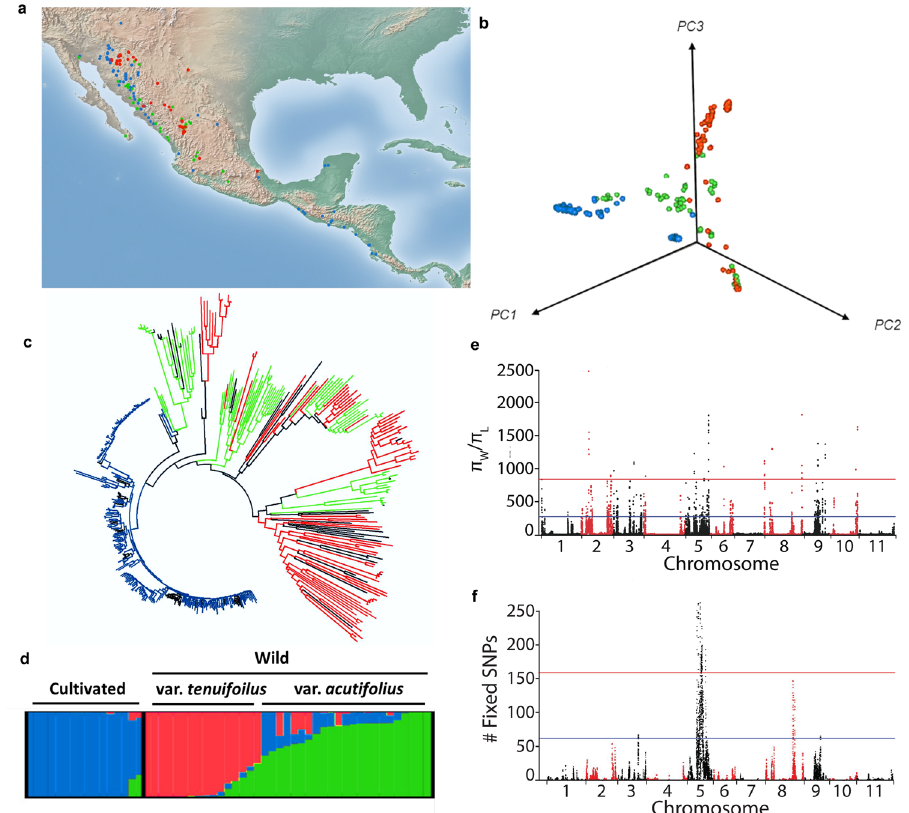
Fig. 4 Population genomics of tepary bean. Geographic distribution ( a ), PCA analysis ( b ), neighbor-joining tree ( c ), and structure analysis ( d ) of the wild and cultivated tepary beans. Cultivated: blue, Wild: red ( P. acutifolius var. tenuifolius ), green ( P. acutifolius var. acutifolius ), Unknown: black. e π ratio distribution over 100k – 10 kb windows across tepary genome revealed the regions that underwent reduction or complete loss of diversity; alternate red and black colors are used to differentiate the 11 chromosomes. f Distribution of SNPs in which one of the allele presents in wild but another allele presents in landraces revealed that Pc05 is involved the most in the adaptation process of tepary; alternate red and black colors are used to differentiate the 11